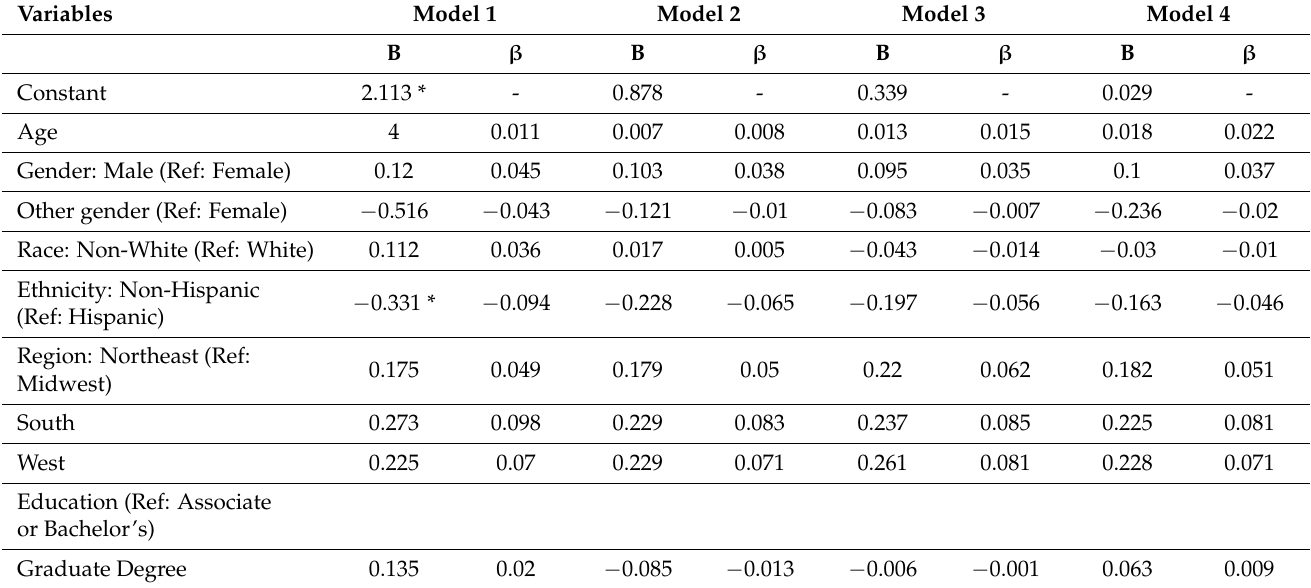
Table 7. Hierarchical multiple regression to predict the likelihood for the sustenance of vaping quitting (N =